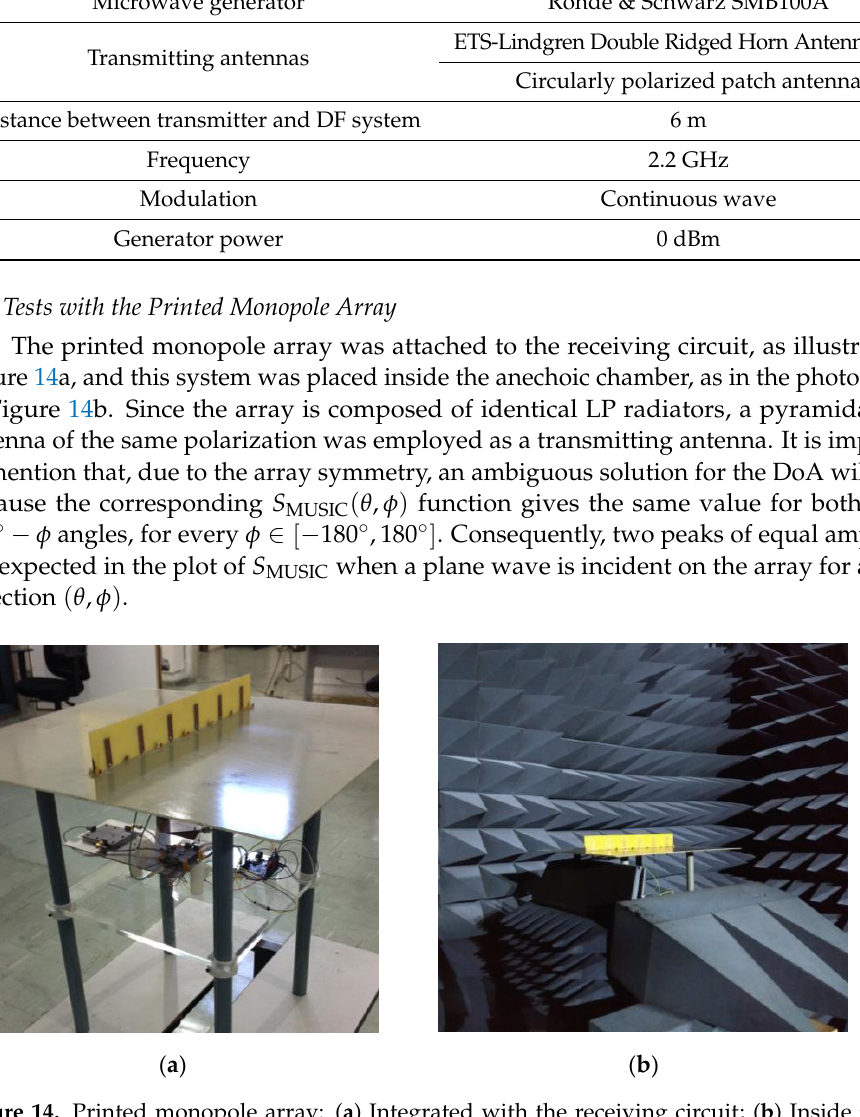
Figure 14. Printed monopole array: ( a ) Integrated with the receiving circuit; ( b ) Inside the anechoic chamber.